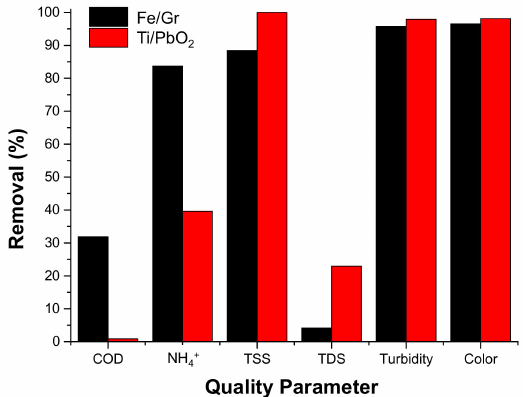
Figure 2. The efficiency of Fe/Gr and Ti/PbO 2 electrodes for leachate treatment (current density = 64 mA/cm 2 , inter-electrode distance = 1.5 cm, pH = 7.5, electrolysis time = 120 min, temperature = 20 ◦ C, and without electrolyte